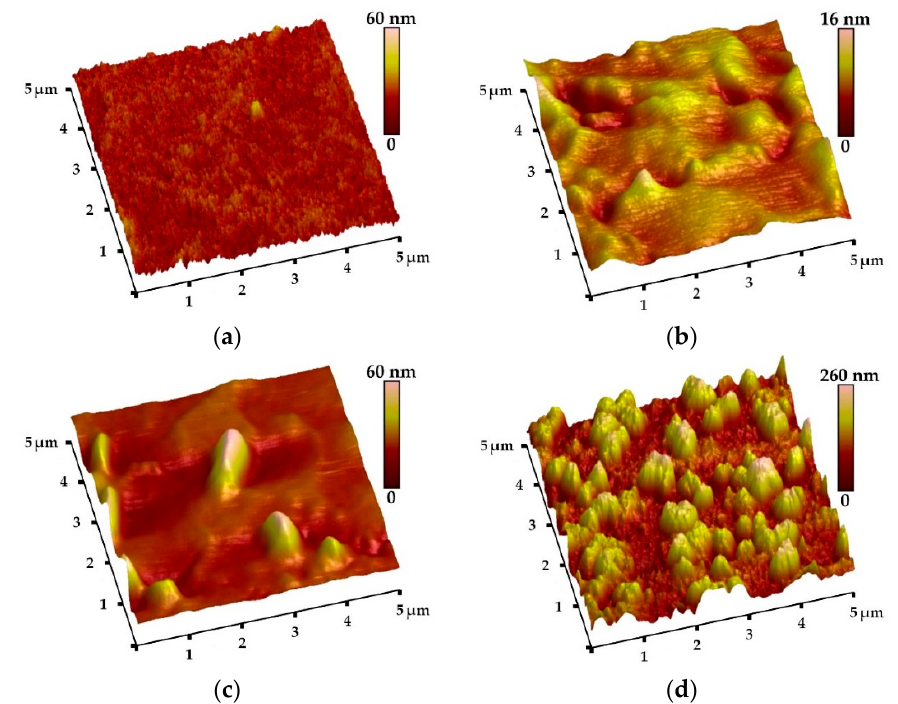
Figure 4. Atomic force microscope (AFM) topography of one-component coatings: TiO 2 ( a ), Al 2 O 3 ( b ), ZrO 2 ( c ), and HAp ( d ), deposited on Ti6Al7Nb alloy substrates.